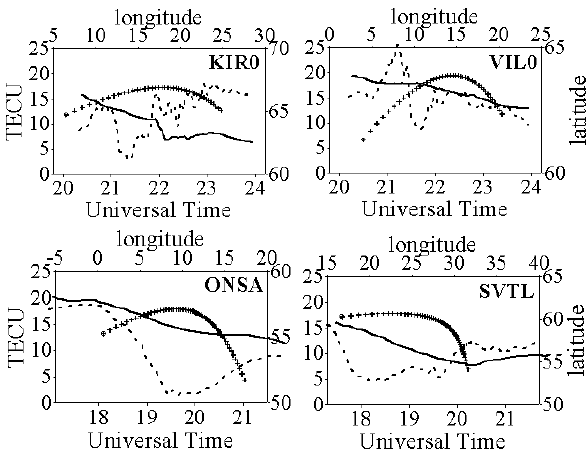
Fig. 5. Temporal TEC variations along individual satellite passes for PRN 30 (top panel) observed at PNSA (57.4 ◦ N, 11.9 ◦ E) and SVTL (60.5 ◦ N, 29.8 ◦ E), as well as for PRN 9 (bottom panel) observed at KIRO station (67.9 ◦ N, 21.1 ◦ E) and VIL0 station (64.7 ◦ N, 16.6 ◦ E) on 11 September (solid curves) and 12 Septem- ber (dots). Crosses show location of satellite traces at ionospheric height in geographic